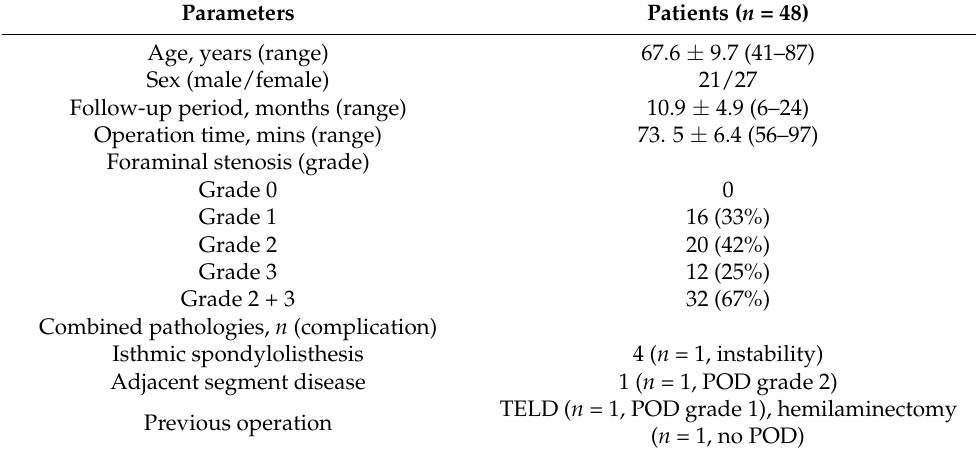
Table 1. Information of the